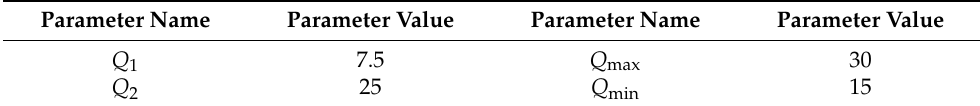
Table 4. The parameters of the Variable droop coefficient.